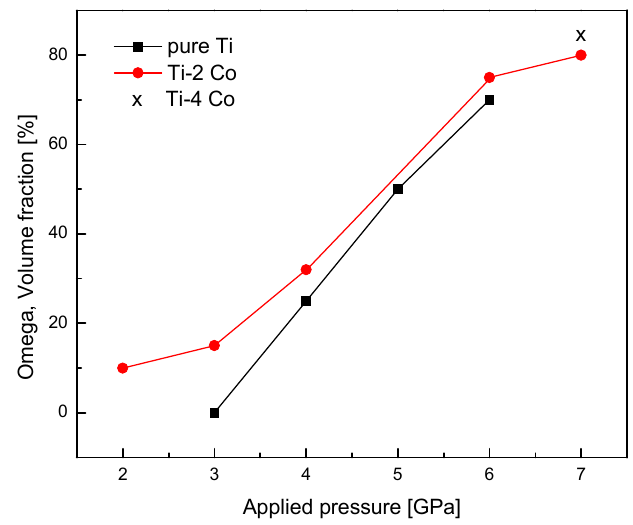
Figure 4. Pressure dependence of the volume fraction of ω -phase after HPT in pure titanium ( squares ) [18], Ti–2 wt % Co alloy ( circles ) and Ti–4% Co alloy ( cross ). ( squares ) [18], Ti–2 wt % Co alloy ( circles ) and Ti–4% Co alloy ( cross